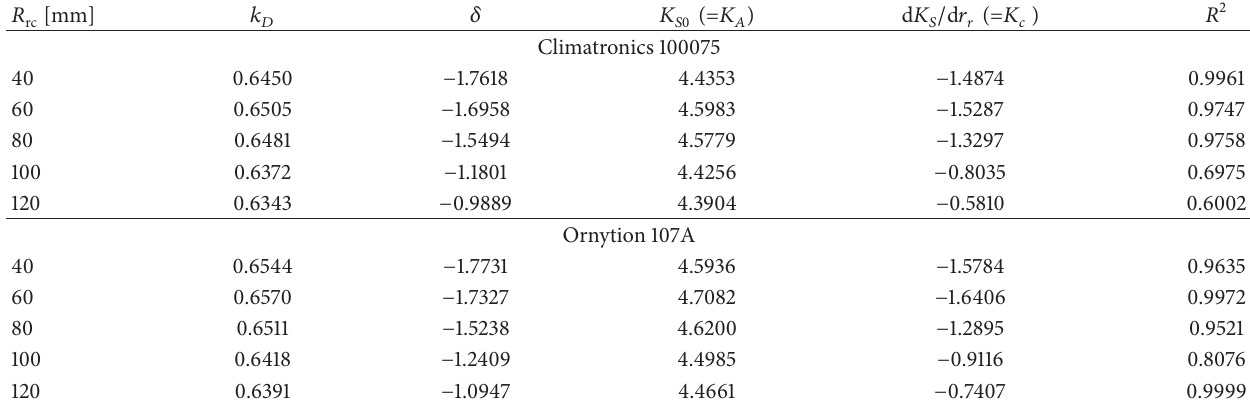
Table 3: Parameters 𝑘 𝐷 and 𝛿 from the fittings of the proposed analytical model (with 𝜀 = 𝐶 𝑚𝑓 = 0 , see expression (24)), to the testing results (see Figure 6). The table also includes the slope, d 𝐾 𝑆 / d 𝑟 𝑟 , the offset, 𝐾 𝑆0 , and determination coefficient 𝑅 2 of the linear fittings for each case. 𝑅 [mm] rc